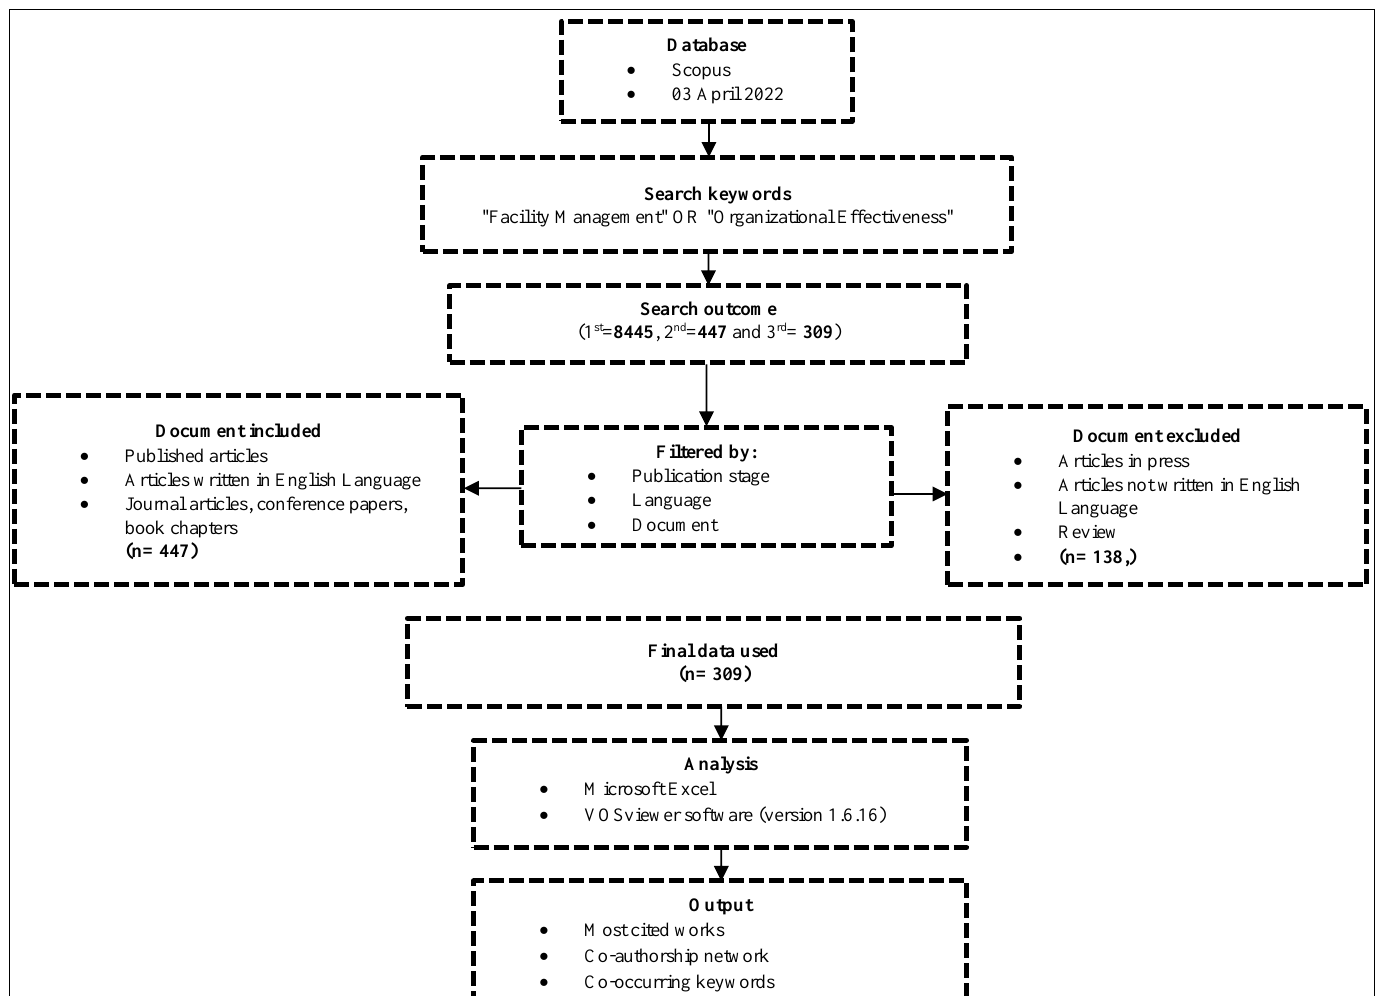
Figure 1: Search flow chat